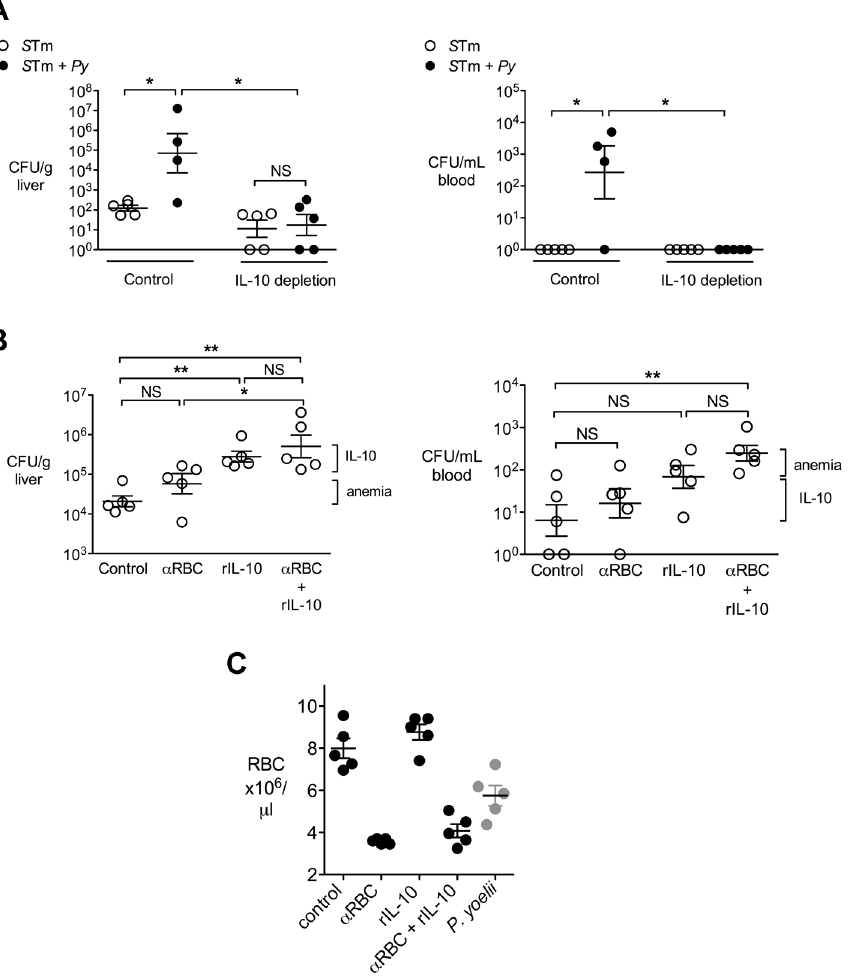
Figure 3. IL-10 contributes to increased systemic loads of S. Typhimurium in malaria parasite-infected CBA mice. A, S. Typhimurium and co-infected CBA mice as described in Fig. 1A, were depleted of IL-10 using a blocking antibody, or treated with a control antibody. At 2 d post- S. Typhimurium infection, CFU of S. Typhimurium were enumerated in liver and blood (n=4–5). Statistical significance was determined using an unpaired Student’s t test on log-transformed values, or a Mann-Whitney U test for groups that include all zero values, and is indicated as *, P , 0.05; **, P , 0.01. B, Mice were treated with either an anti-RBC antibody to induce anemia, recombinant IL-10 (rIL-10) or both. At 4 days post- S. Typhimurium infection, CFU were enumerated in liver and blood (n=5). Dots represent individual mice and bars represent the mean 6 SEM. Brackets indicate the contributions of anemia and IL-10 to increased bacterial colonization. C, Levels of anemia in experimental groups from ( B ) at 4 d post IG infection. The number of circulating RBC in mice infected with P. yoelii at 14 d after inoculation is given as a reference. Statistical significance was determined using one-way ANOVA with a Tukey’s post test *, P , 0.05; **, P , 0.01.